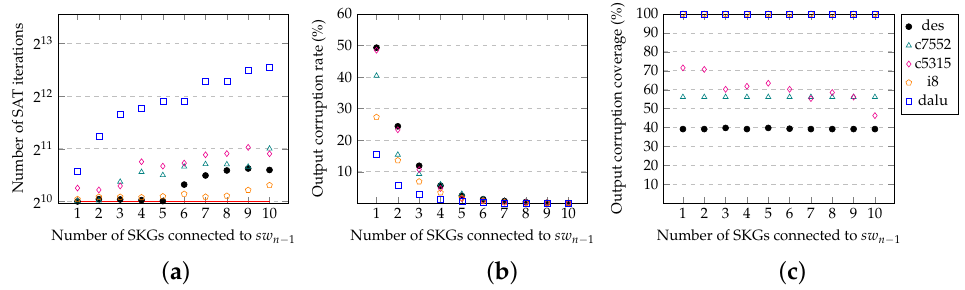
Figure 12. Evaluation of SAT resilience and output corruption according the switch-signals used: ( a ) Number of SAT iterations, ( b ) Output corruption rate, ( c ) Output corruption coverage.